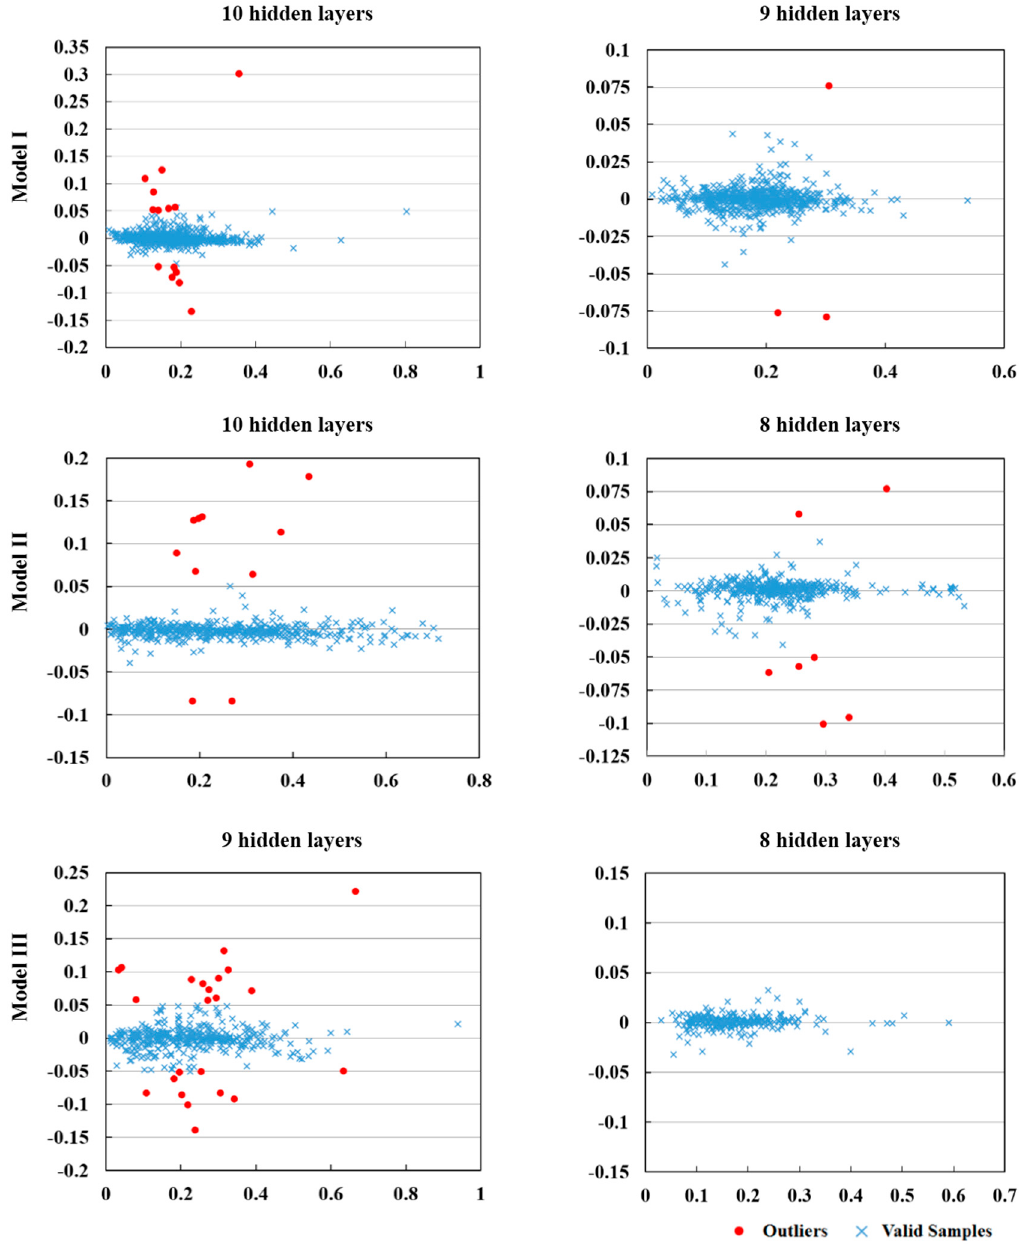
Figure 5. The residual scatter plots of the three groups of optimal models.